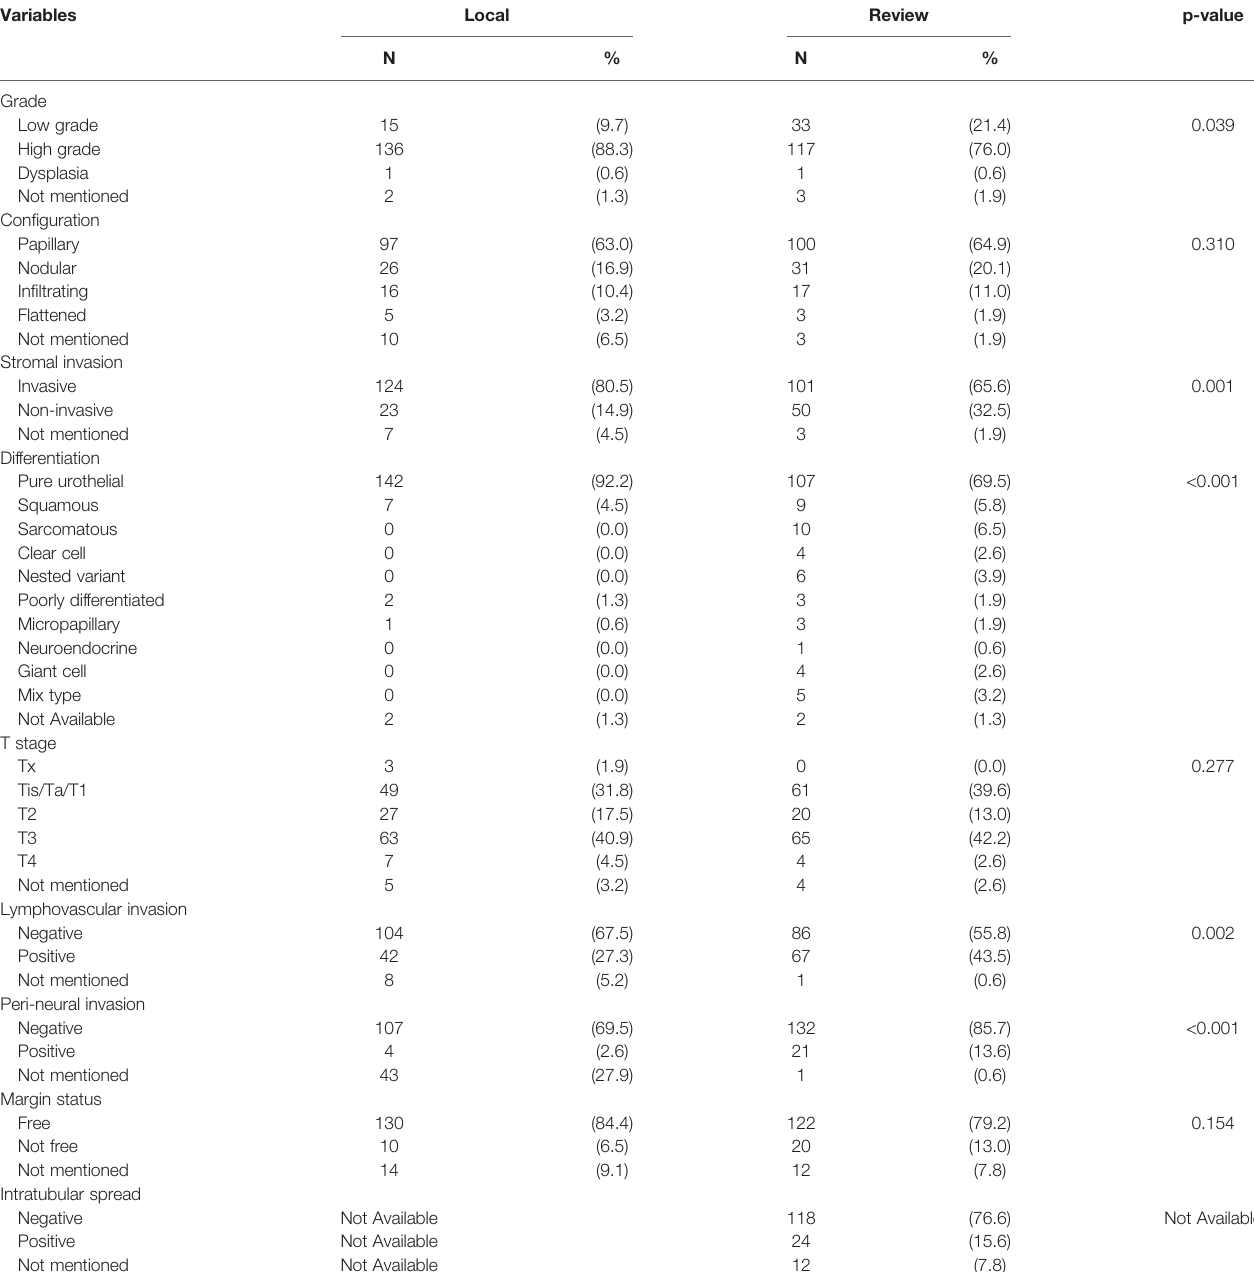
TABLE 2 | Histopathologic characteristics recorded by the review and local